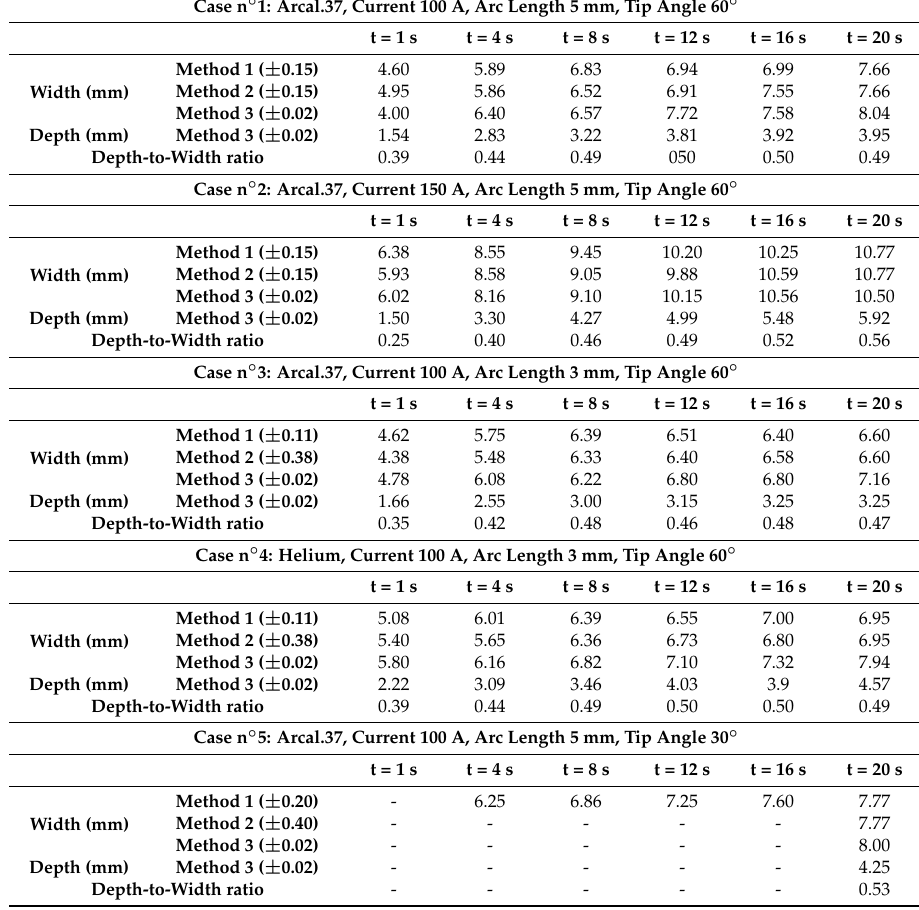
Table 2. This table indexes width, depth and depth-to-width ratio values using the three methods for the different configurations tested. Width values are estimated with high speed imaging (Method 1) during the interaction and with a picture of the top surface of the electrode at the final instant (Method 2). Metallographic investigations (Method 3) allow evaluating width and depth after the interaction. Uncertainties associated to each method are mentioned between